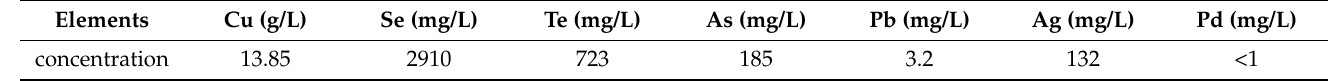
Table 1. Analysis of primitive pregnant solution from copper anode slime